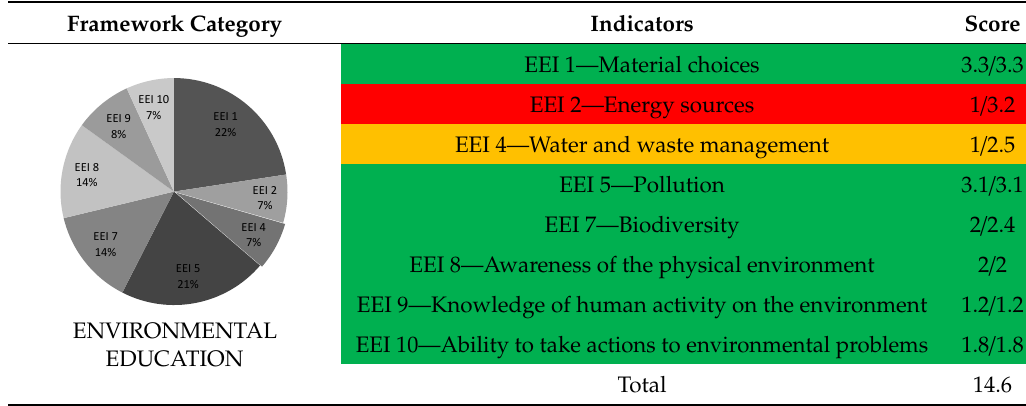
Table 9. RAG rating of Environmental Education Indicator in Louroujina.